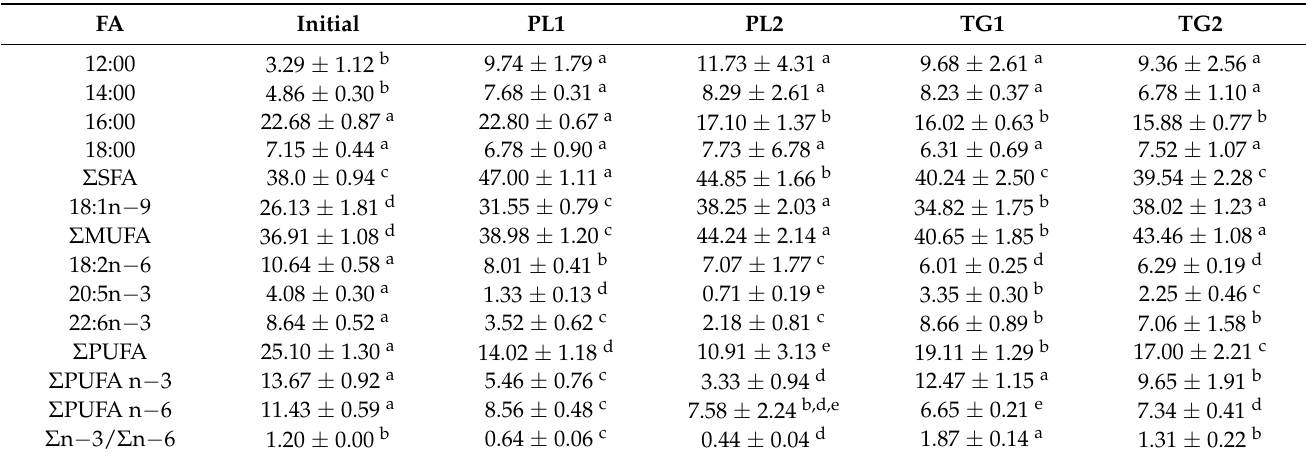
Table 7. Fatty acid percentages of the neutral fractions of the muscles of dusky grouper juveniles fed the experimental